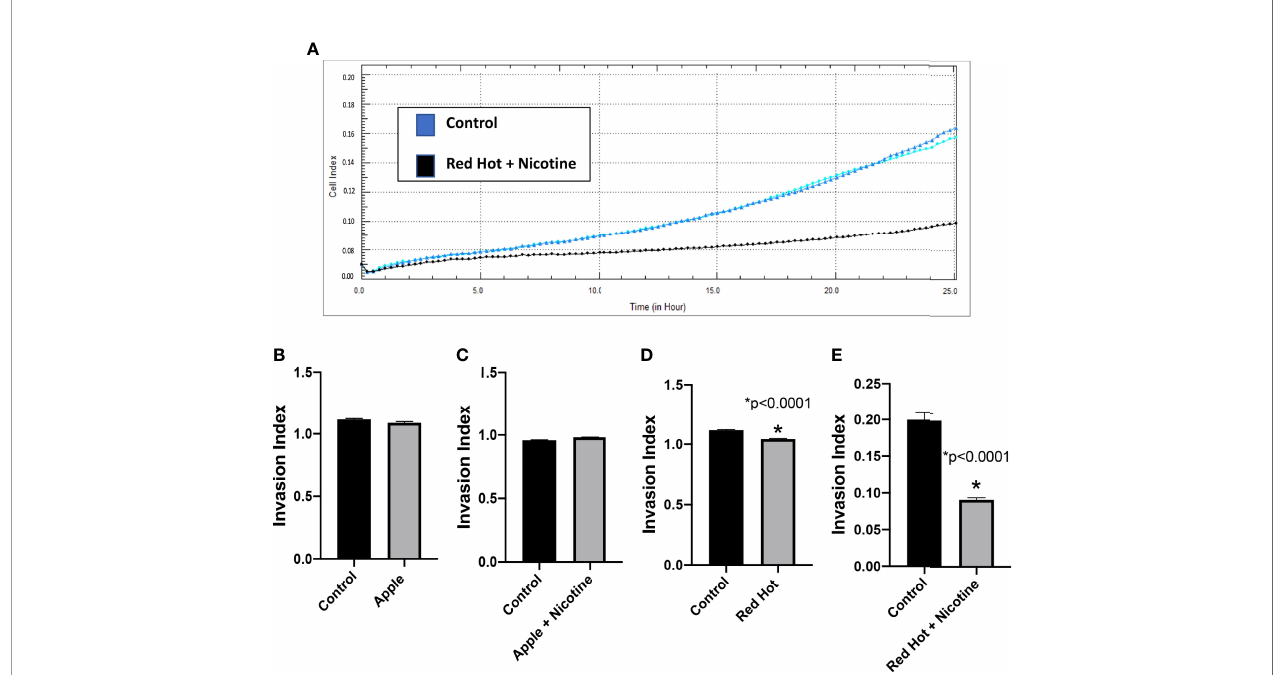
FIGURE 5 | Cal27 invasion with Green Apple or Red Hot EVE. A representative diagram of readout cells over time invasion is shown in (A) . Green Apple EVE did not affect Cal27 invasion in cells with or without nicotine (B, C) . Red Hot EVE reduced Cal27 invasion in cells with and without nicotine (D, E) as compared to untreated controls. Data are shown with * p ≤ 0.05.